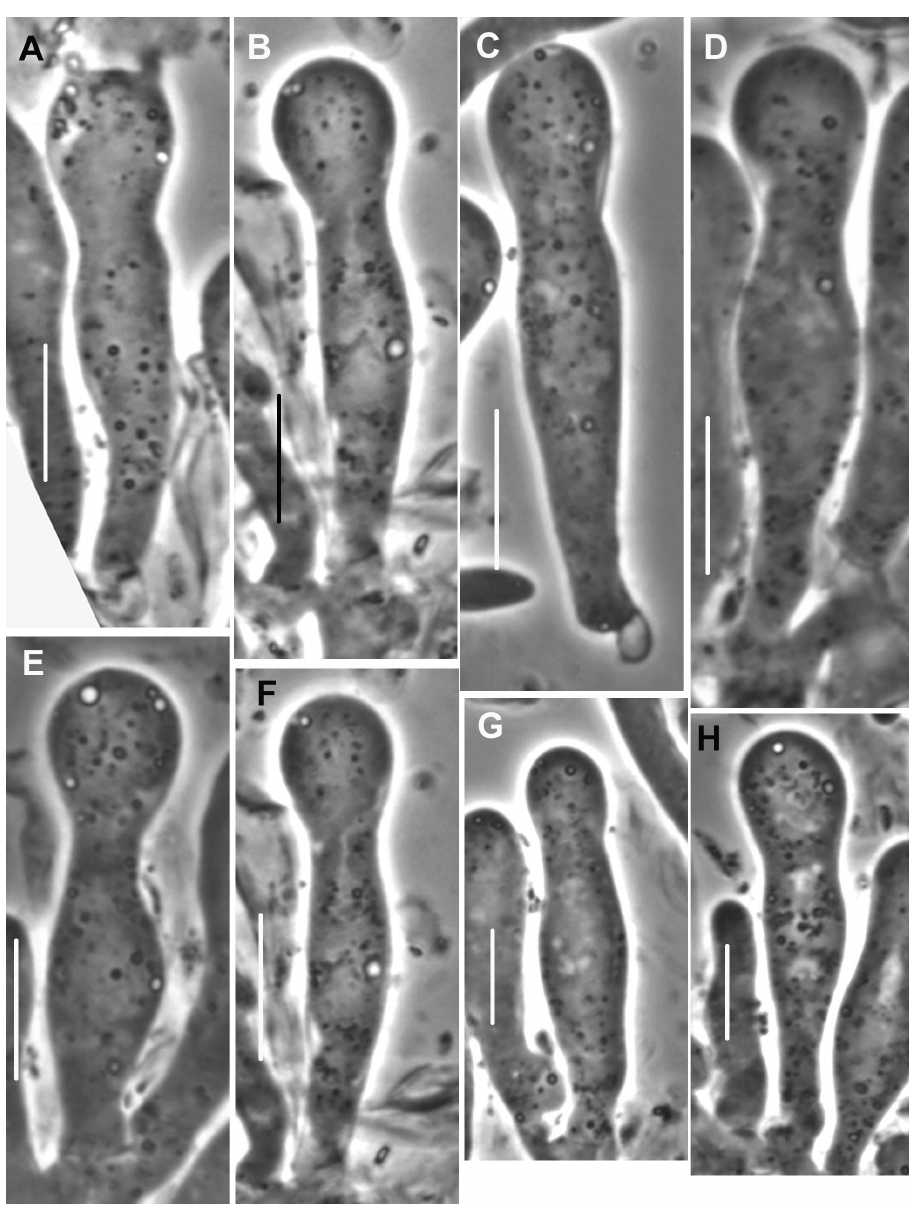
Figure 56. Mycetinis opacus . Ampulliform hymenium structures. A Basidium with ampulliform shape B–H Sterile ampulliform structures. Standard bars = 10 µm. TFRB 14629 (TENN-F-69344).